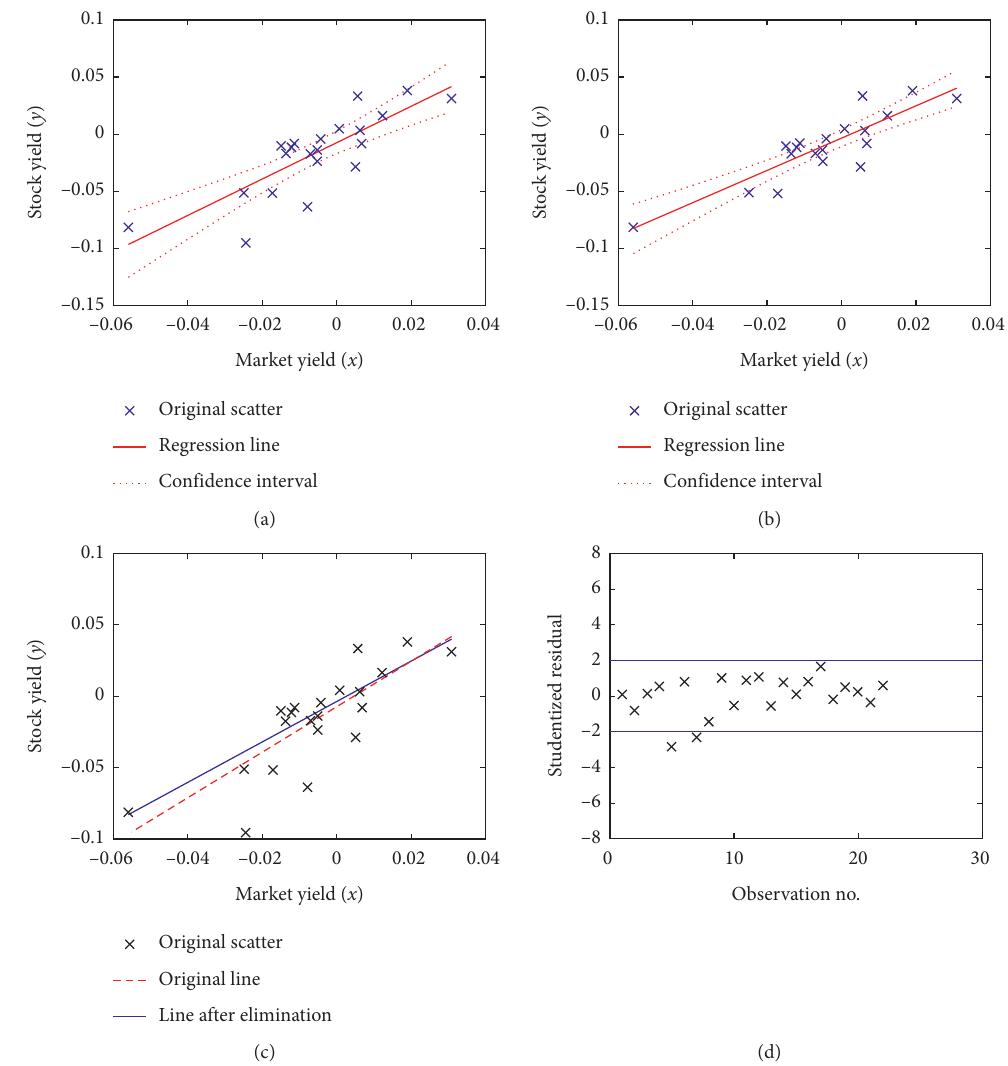
Figure 3: Market model method fitting map. (a) Before eliminating abnormal value. (b) After eliminating abnormal value. (c) Before and after eliminating abnormal value. (d) Studentized residual